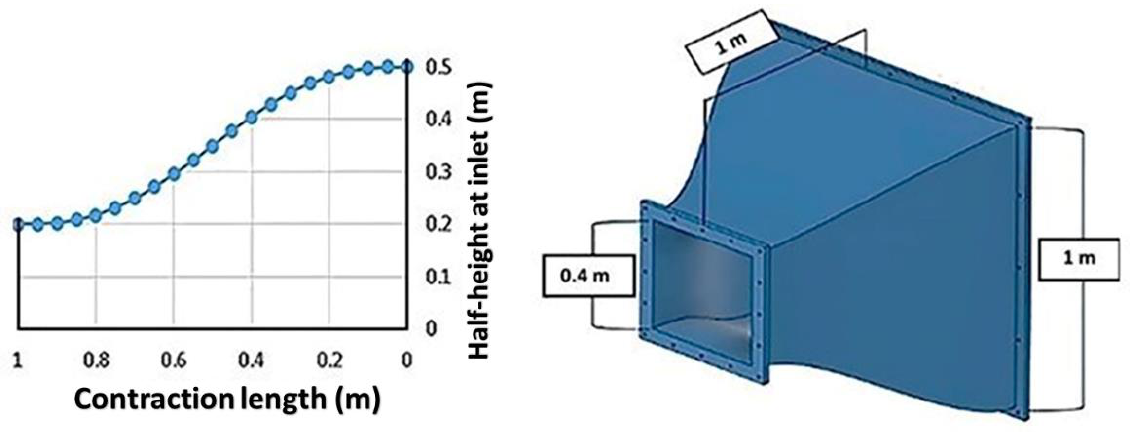
Figure 4. Contraction cone: upper half profile and 3-D model.